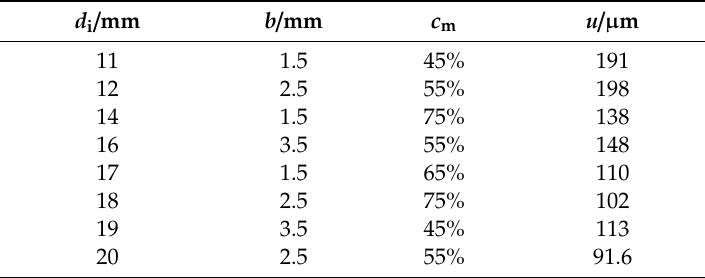
Table 8. Verification samples for the Kriging model.